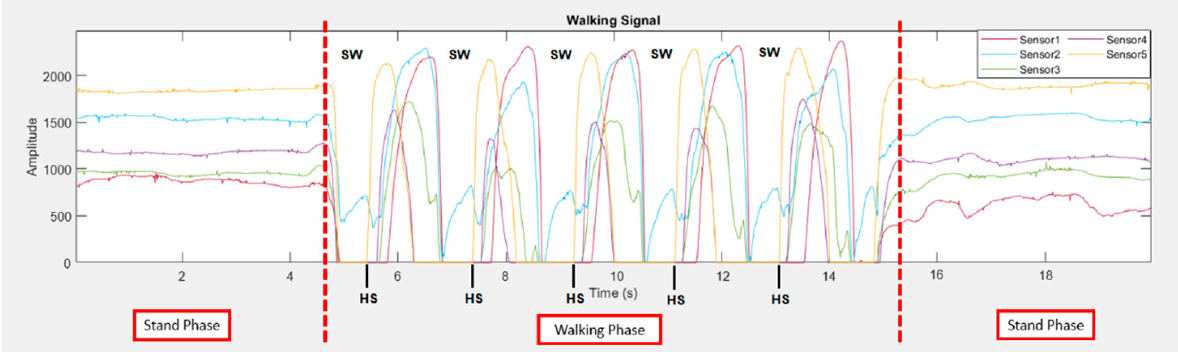
Figure 3. Examples of measured signals from five sensors. (SW: swing, HS: heel strike).